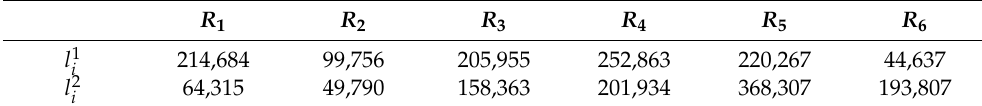
Table 2. The length of the rescue path from each emergency rescue base to the accident spot (m). R 1